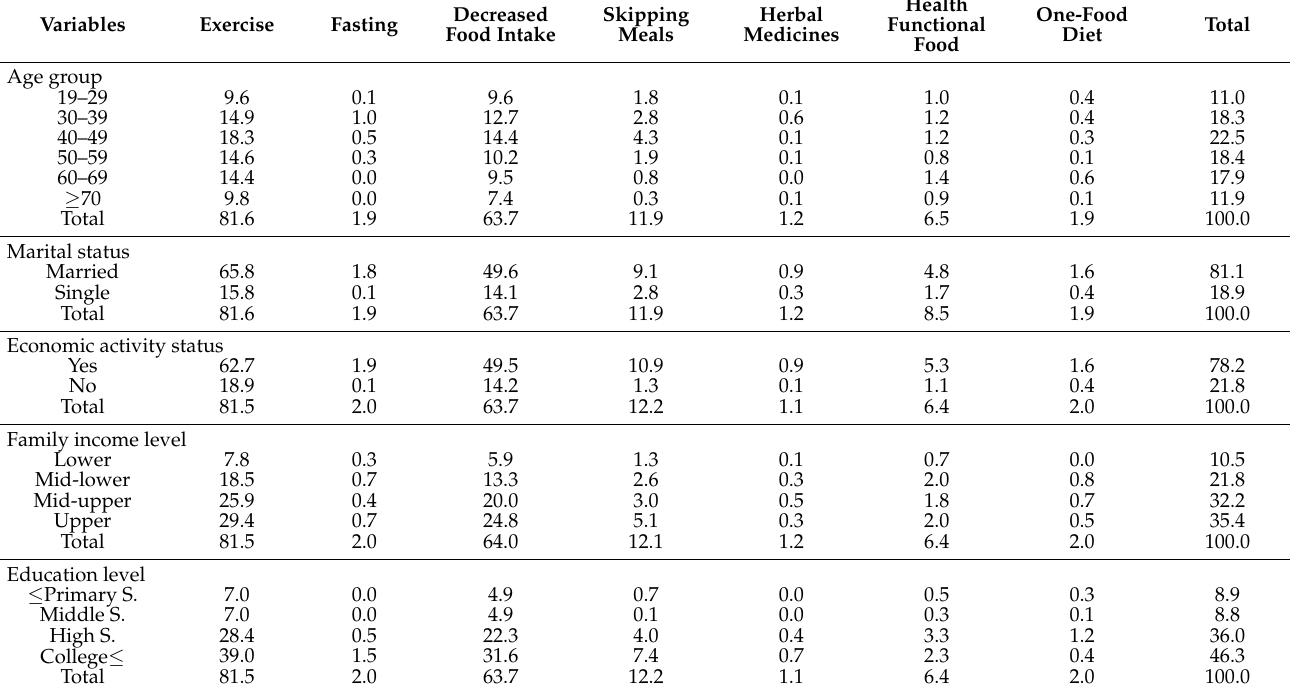
Table 4. CIHA for weight management according to general characteristics in Korean obese men population ( ≥ 19 years